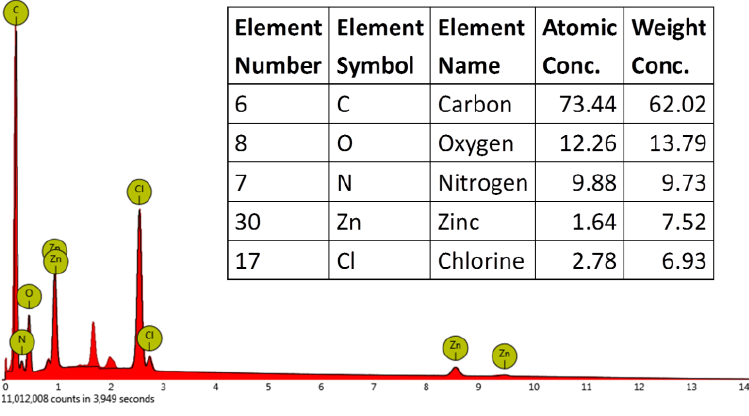
Figure 16. EDX spectra of xerogel 1 with addition of 1.0 eq. of Zn 2+ .